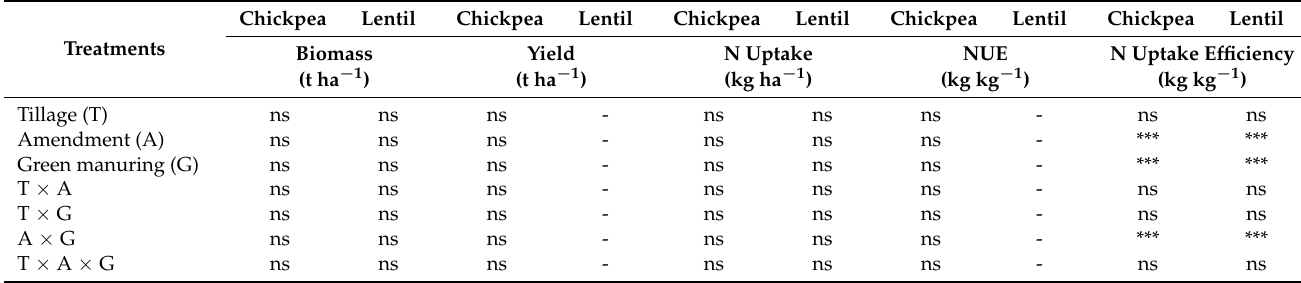
Table 2. Analysis of variance for the effect of tillage system, organic amendment, and green manuring on biomass (dry matter), yield, and N efficiency parameters of chickpea and lentil crops.